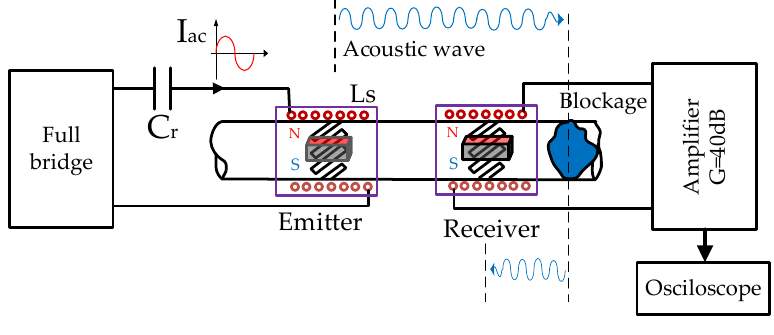
Figure 2. Experimental setup.